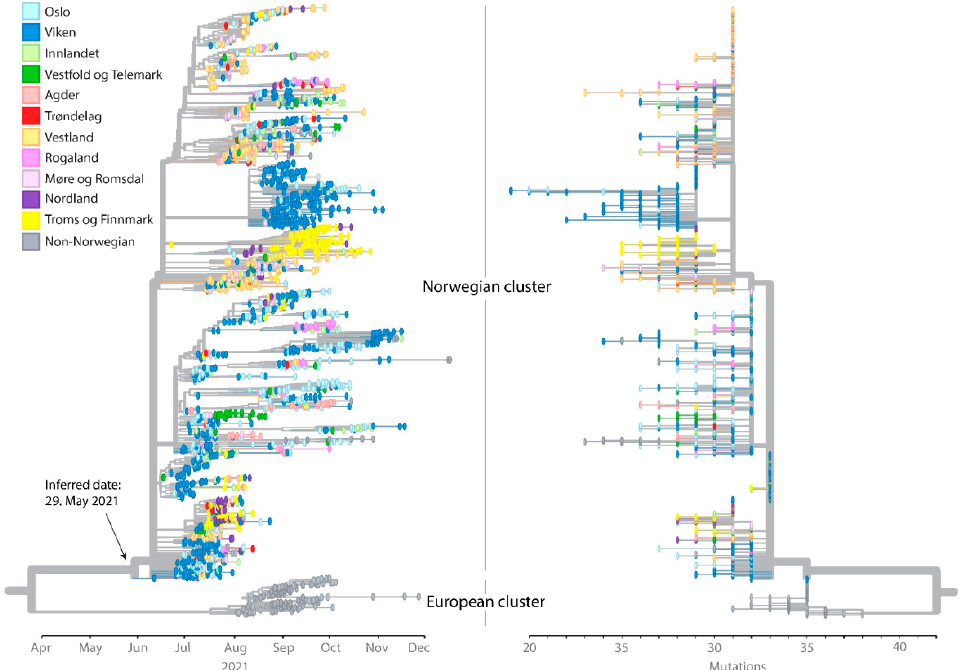
Figure 2. Phylogeny of AY.63. Phylogenetic analysis of AY.63 with a selection of the closest non-AY.63 Delta sequences as the outgroup (not shown). The tree on the left has the branch tips arranged according to sample date, with the internal nodes positioned on their inferred dates according to TreeTime; while on the right, the branch tips are arranged according to the genetic divergence from the root of the tree. Norwegian samples are colored according to region, and the non-Norwegian samples are indicated with grey circles.